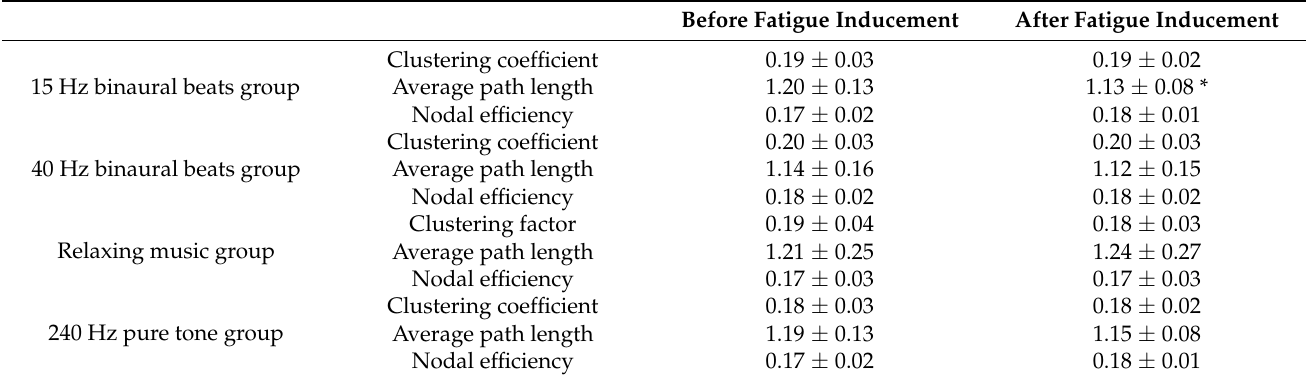
Table 3. The topological structure of the theta band in the eyes-opening state. Before Fatigue Inducement After Fatigue